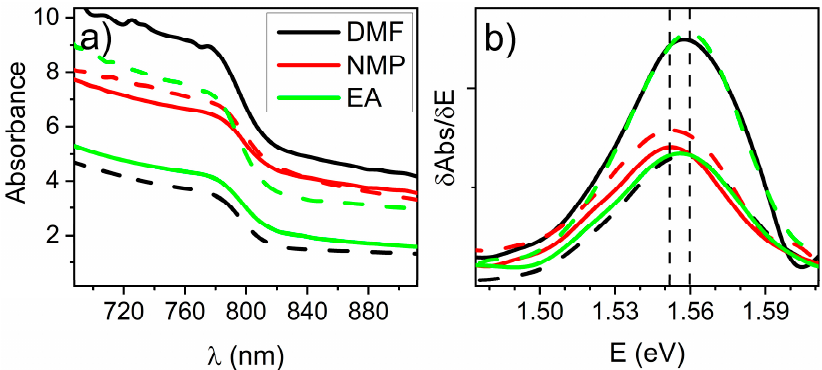
Figure 3. ( a ) Typical absorbance spectra of the perovskite structures obtained using different solvents